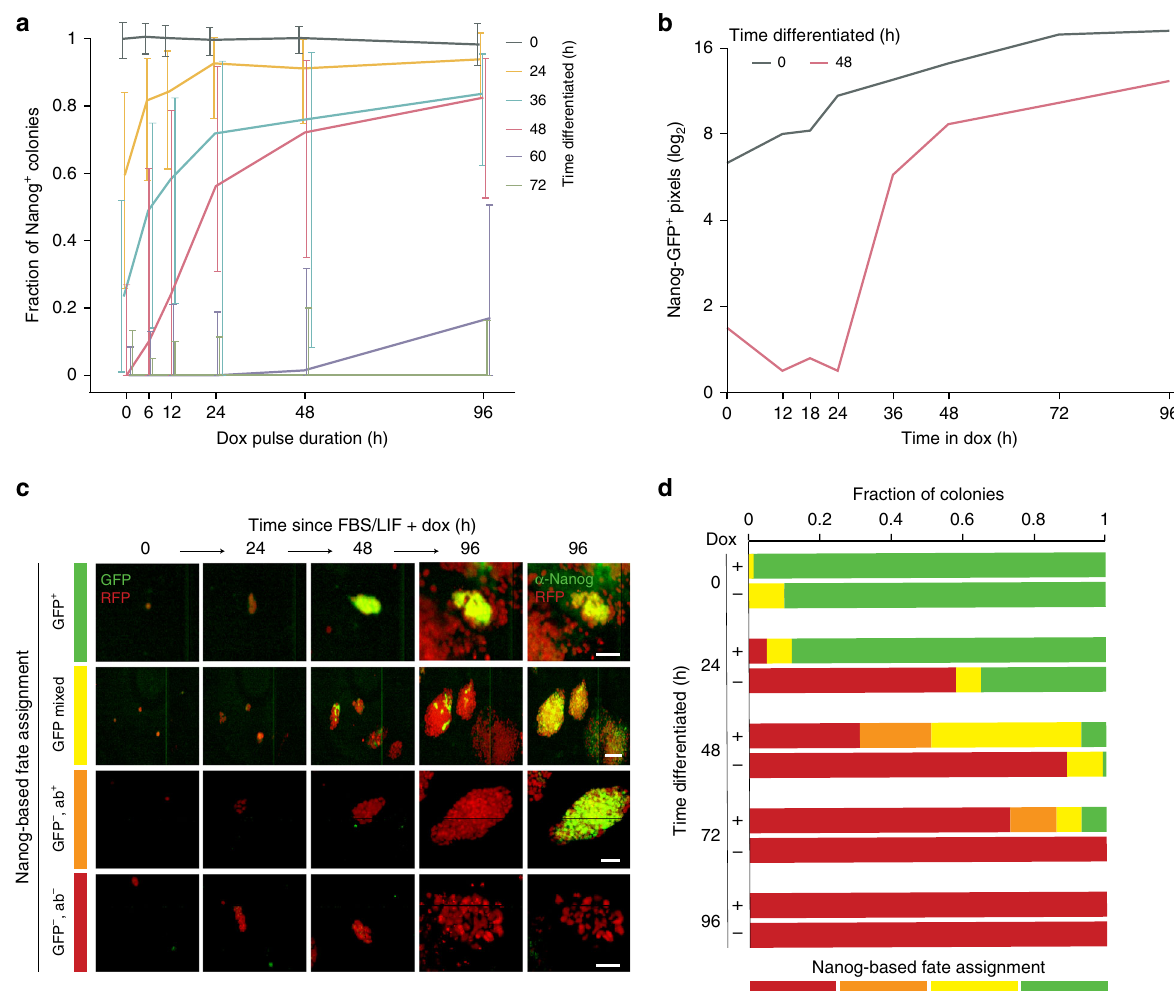
Fig. 2 Transition from high to low-ef fi ciency reprogramming during early differentiation. a Cells differentiated for our selected time intervals were seeded in serum/LIF + dox condition for the speci fi ed durations prior to dox withdrawal. The x -axis represents the dox duration and y-axis shows the normalized fraction of Nanog + colonies after spending the rest of the 96 h experimental duration in FBS/LIF. Each colored line shows the fraction of cells for each pulse duration that were differentiated for the respective intervals. Error bars represent 25 th − 75 th percentile. All experiments were performed with n =